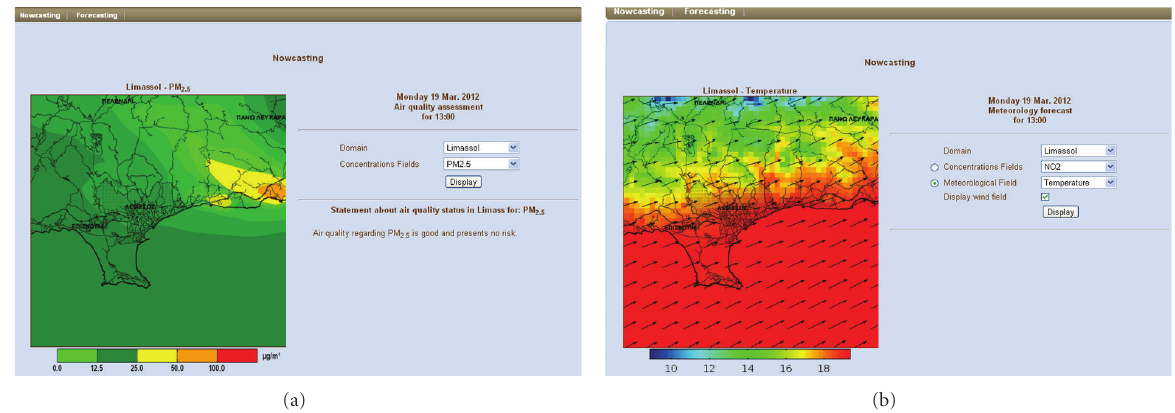
Figure 2: Snapshots of nowcasting for pollutant concentrations (a) and meteorological parameters